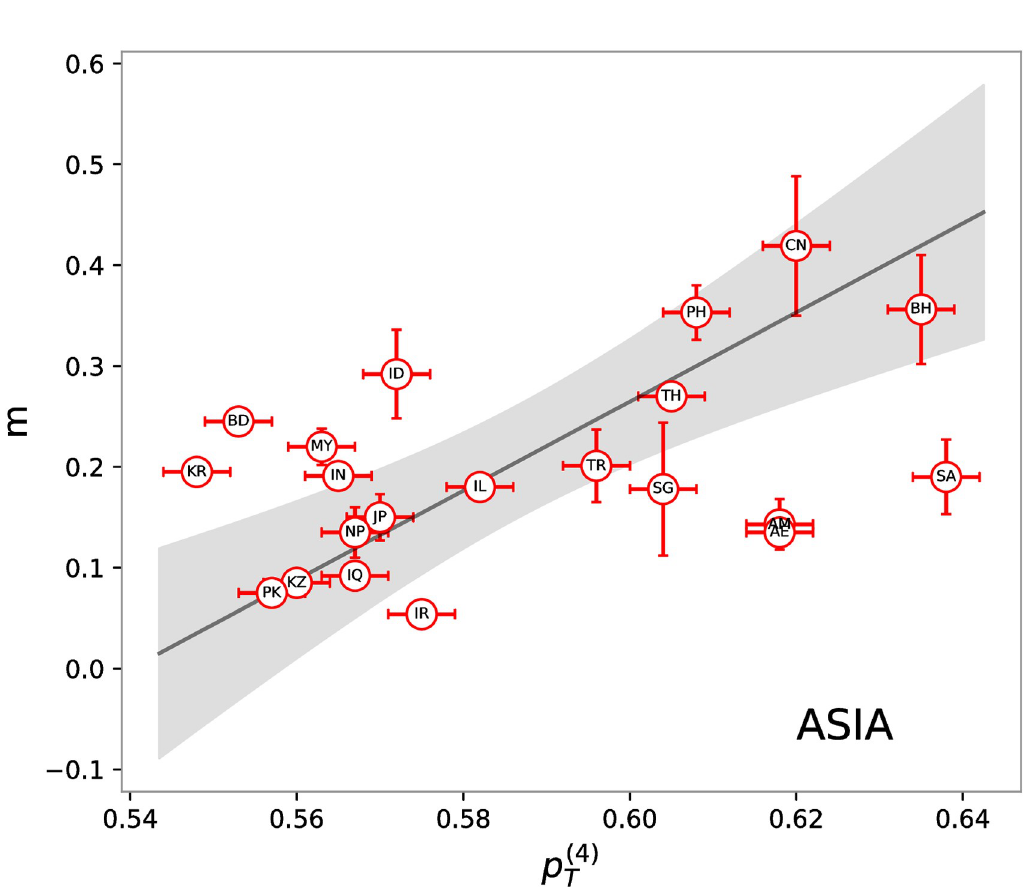
Fig 5. Inverse characteristic times of the epidemic exponential phase extracted from cumulative infection curves, m vs obtained from Eq (11) using the ABO sets of rules and using the blood type frequencies in theoretical prediction, p ð 4 Þ T Table 2. Each dot corresponds to one of the 21 analyzed countries in the Asiatic region named according to the 2-letter ISO code and reported in Table 2. The black line represents the best solution of a linear fit. The uncertainty on p ð 4 Þ ffiffiffi p 2 4 D f where Δ f = 10 − 3